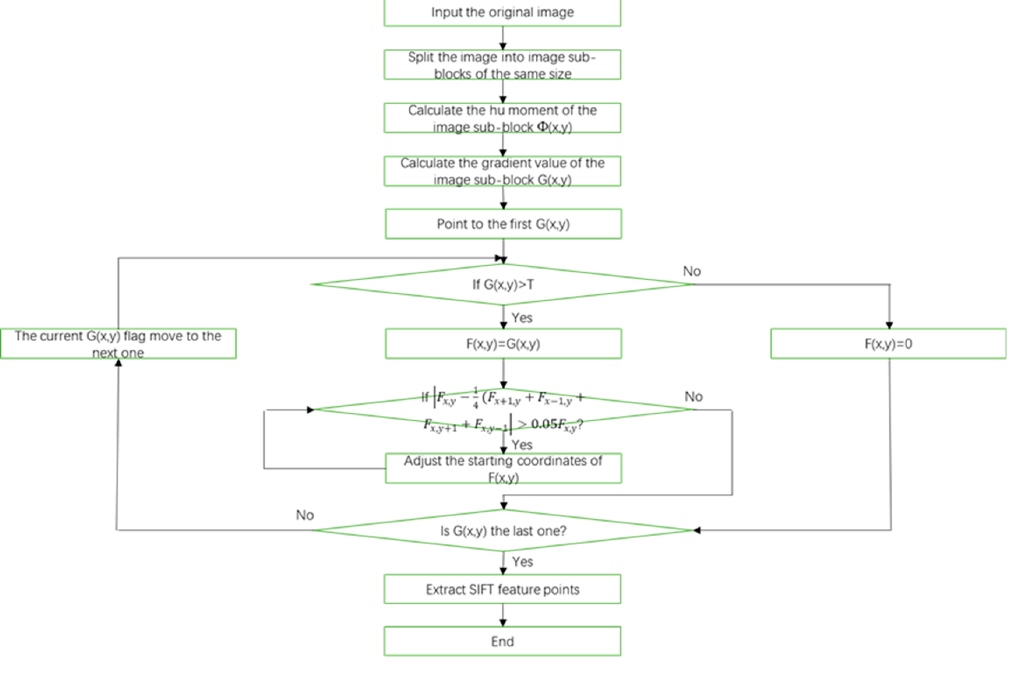
Figure 3. Flow chart for a scale-invariant feature transform keypoints extraction method based on edge categories (EC-SIFT) algorithm.